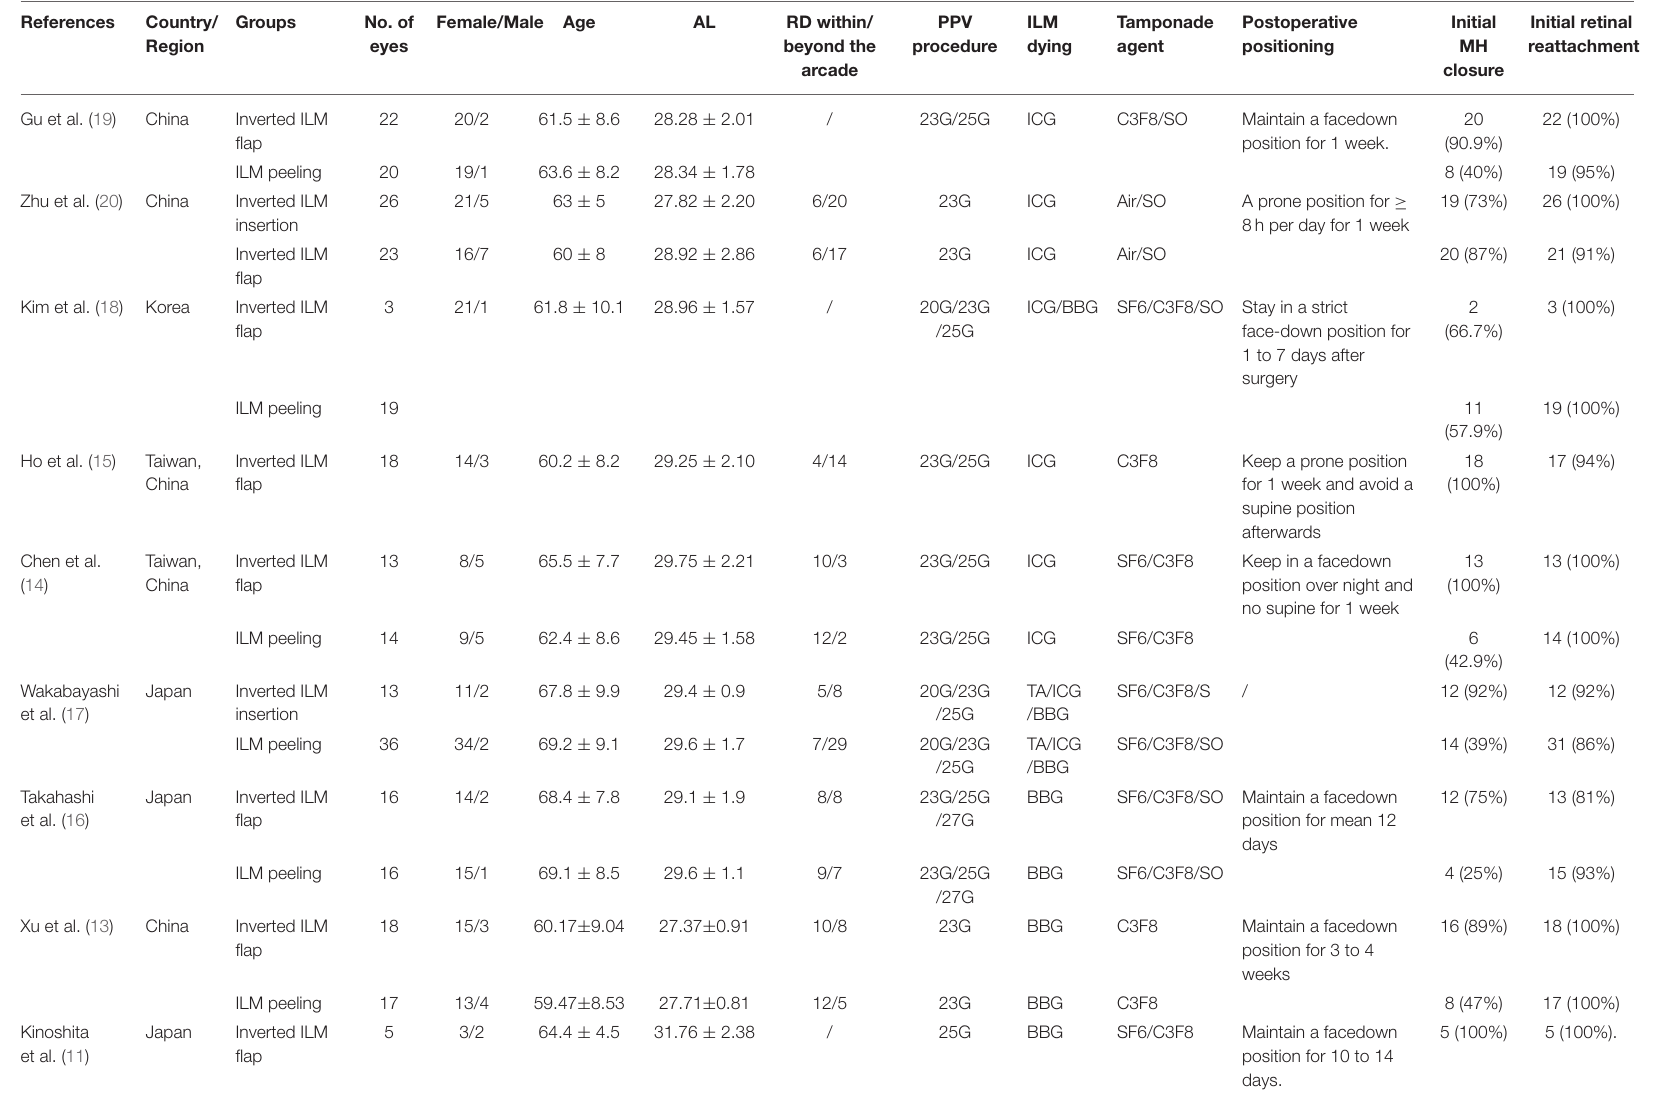
TABLE 3 | Published studies about macular hole retinal detachment (MHRD) in the last 5